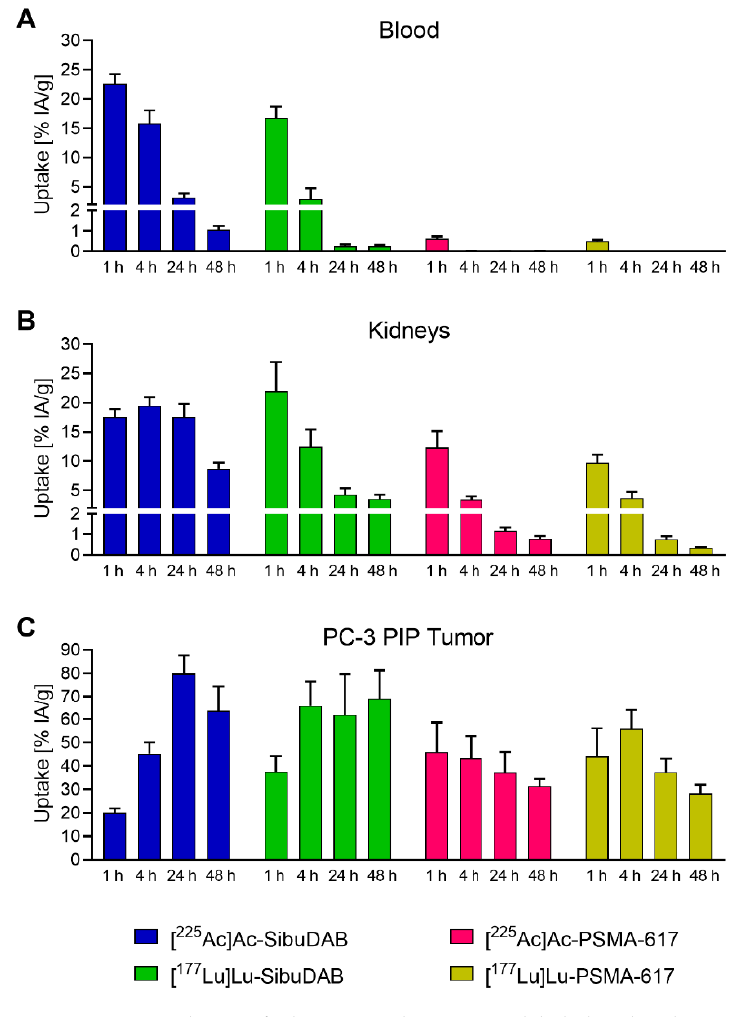
Figure 5. Accumulation of SibuDAB and PSMA-617 labeled with either actinium-225 or lutetium-177 in ( A ) blood, ( B ) kidneys and ( C ) PSMA-positive PC-3 PIP tumor xenografts. Data obtained for